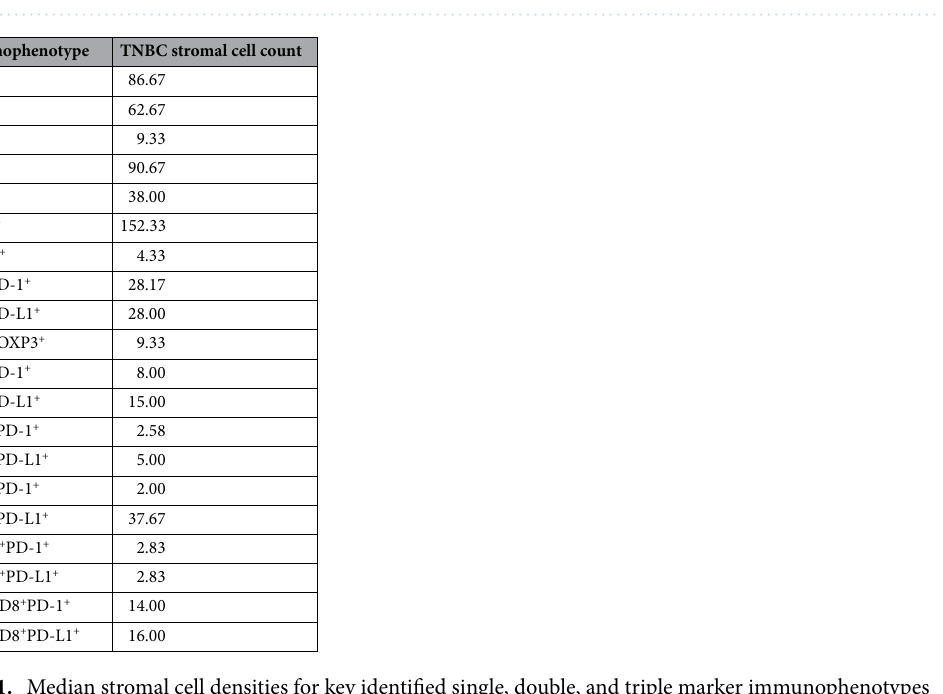
Figure 1. Matched haematoxylin & eosin (H&E) stained sections and multiplexed immunofluorescence (mIF) images from TMA cores of 2 patients tumours stained using Opal reagents: CD3 white, CD8 pink, CD20 orange, CD68 purple, PD-1 turquoise, PD-L1 yellow, FoxP3 green and Pan-CK red. DAPI nuclear counterstain is dark blue.. Patient 1 ( A – D ) & patient 2 ( E – H ) ( A , E : H&E × 200; B , F: mIF × 200; C and G: mIF × 400; D and H: H&E × 400).